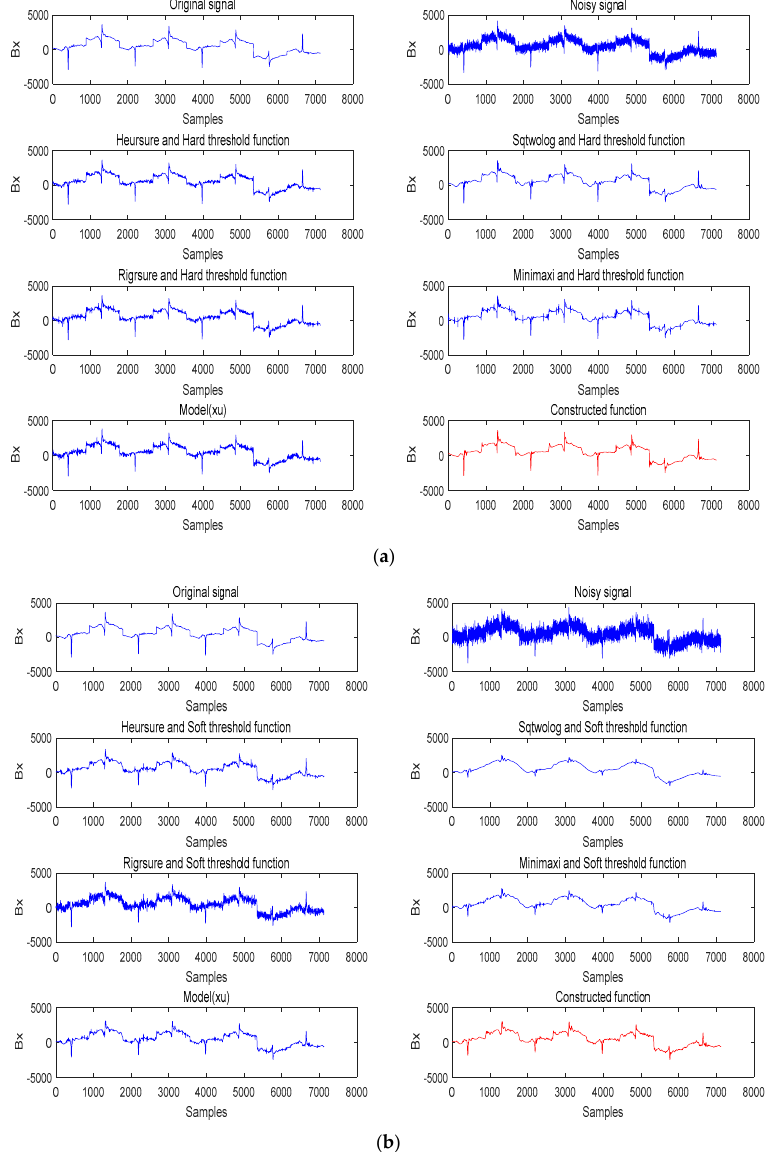
Figure 17. Comparison of signal processing results ( a ) hard threshold function; ( b ) soft threshold function. Table 3. Conventional wavelet threshold denoising method.